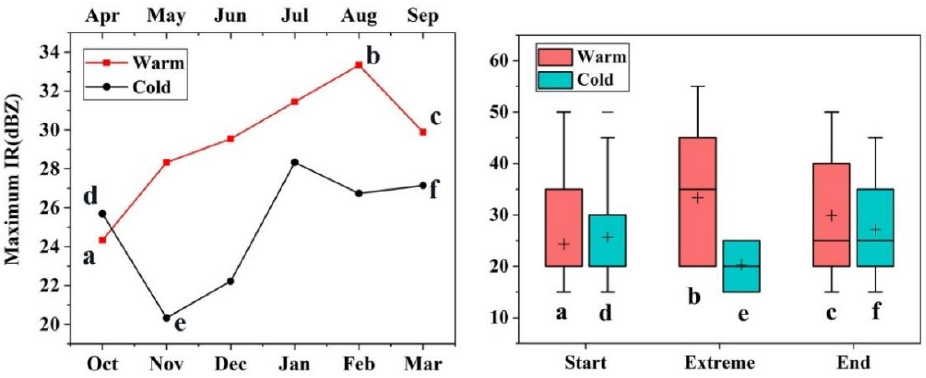
Figure 4. Monthly variation and extreme trends of instantaneous reflectivity (IR) of urban impervious surface (a and d represent the beginning of warm season and cold season, b and e are extreme cases, c and f are the end of season).